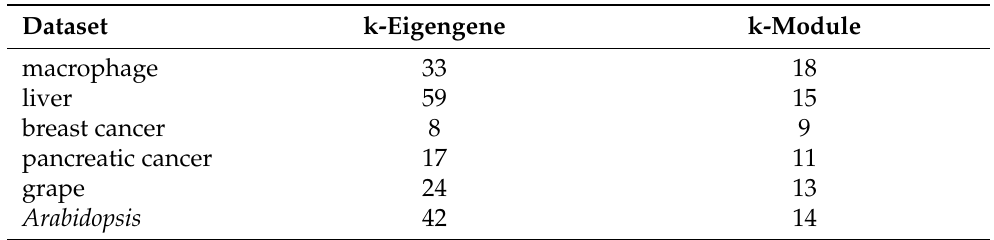
Table 1. The numbers of iterations of the k-eigengene and k-module algorithms. The k-module algorithm has fewer iterations in most of the